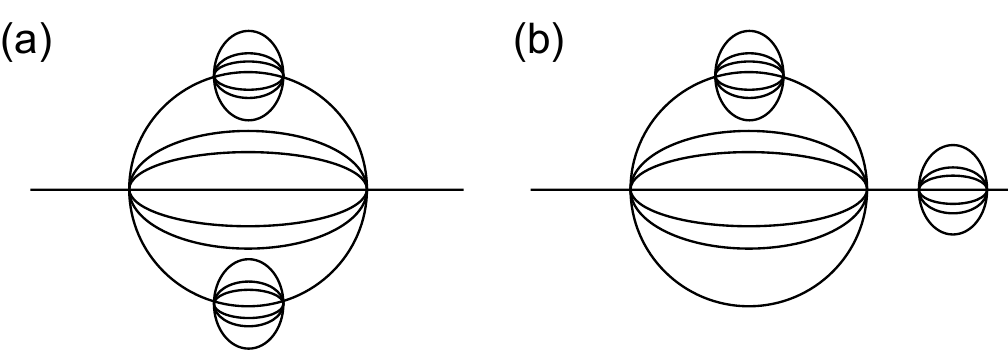
(cid:0) (cid:1) Figure 6 . Two O J 6 examples of the planar graphs of that survive the large- N limit. Only graphs of form (a), where melons are inserted into melons, survive the large q limit. Notice that (cid:0) (cid:1) there are O q 2 graphs of form (a), while there are only O ( q ) graphs of form (b). This is because there are O ( q ) locations at any depth of a given graph to insert another melon; however, there are typically only O (1) locations to thread another melon. Accordingly, we take our coupling J p to equal J = 2 q . Consequently, the O ( q ) combinatorial enhancement gained for each new melon insertion is canceled by the J 2 = J 2 = (2 q ) factor accompanying said melon. This q -scaling of the coupling isolates the in(cid:12)nite subset of the planar graphs where the graphs are two copies of a tree that are then glued together (a.k.a. \doubletree" graphs) such as (a). All non-doubletree graphs such as (b) are suppressed in q since they receive factors of J 2 = (2 q ) for each melon, but do not receive the necessary number of q combinatorial